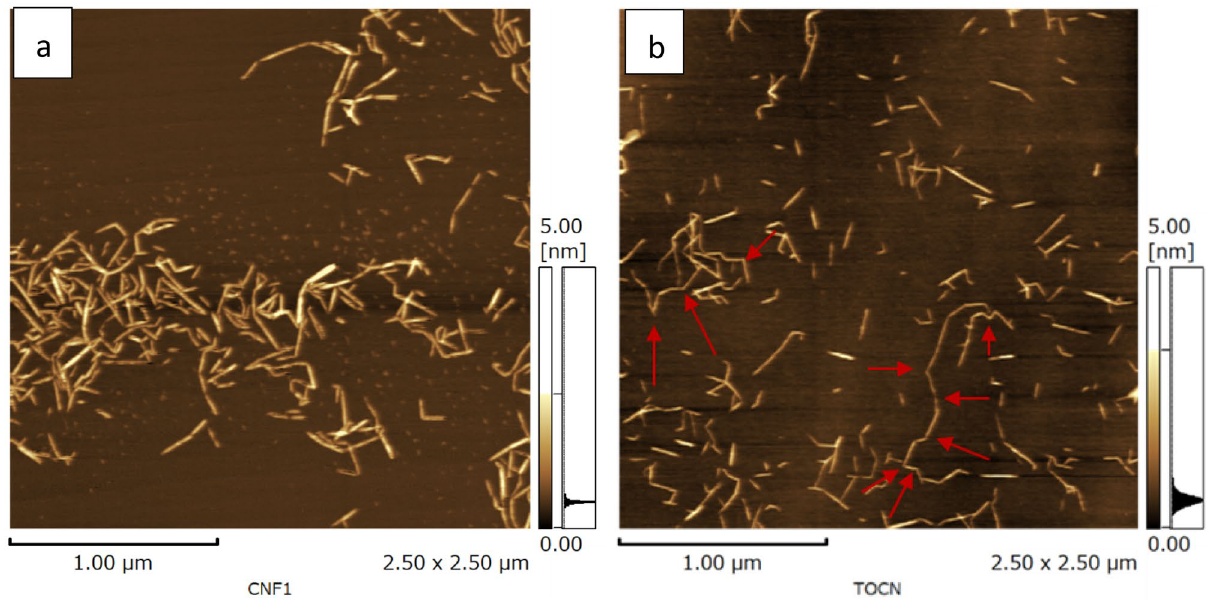
Figure 1. AFM images of TEMPO-CNFs after heated. The sample was prepared by heating an aqueous suspension containing 0.2 wt% of the as-produced TEMPO-CNFs in 150 °C saturated water vapor for 2 or 4 h. The samples were diluted 1/1000 with 80% ethanol. After 4 h of heating, the as-produced TEMPO- CNFs unzipped into shorter lengths of fibers ( a ); after 2 h of heating, both short and long lengths fibers were observed ( b ). The long length fibers curved and twisted (pointed by red